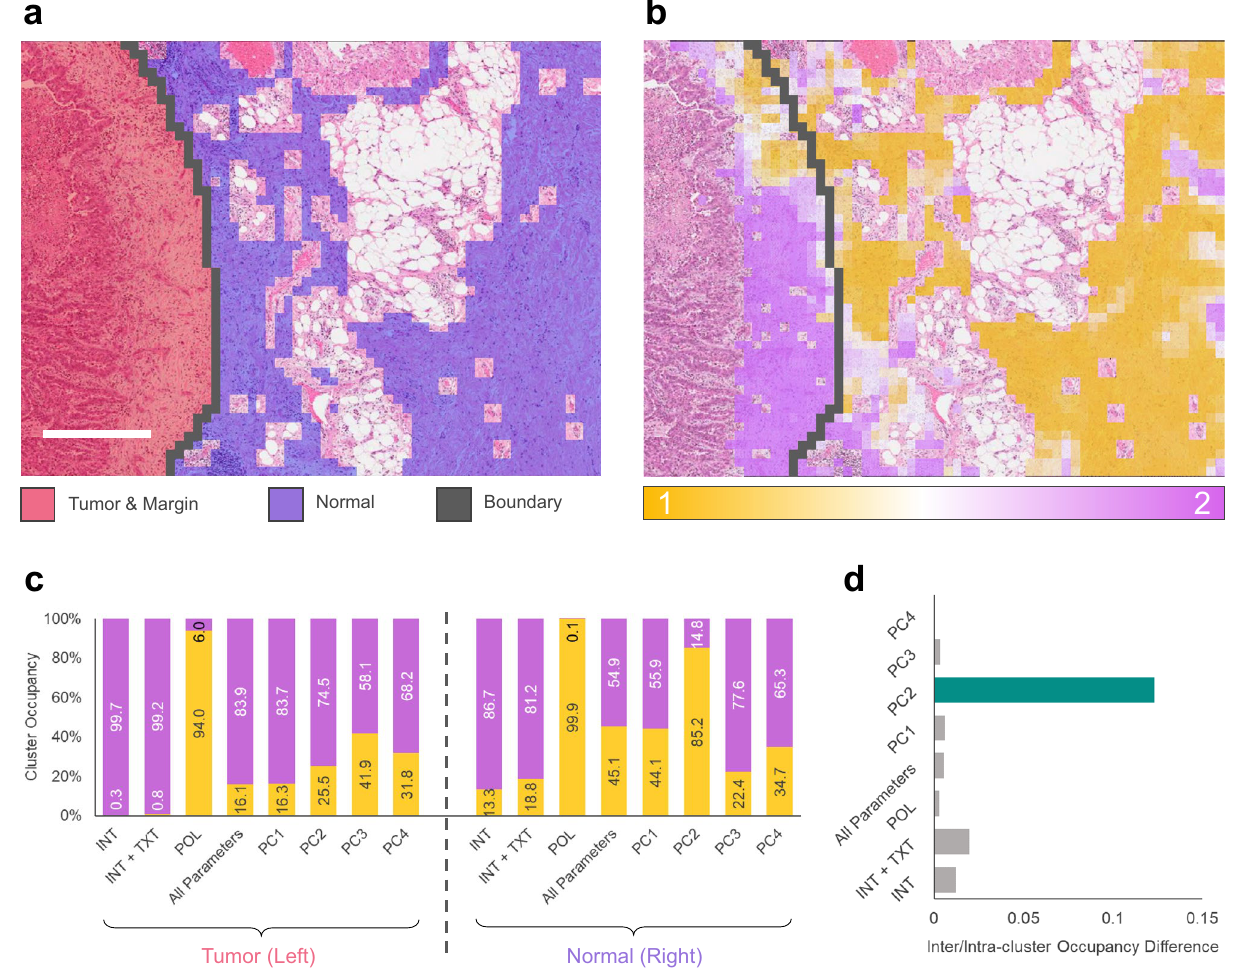
Figure 4. Tumor margin estimation. A ground truth map was generated to highlight the tumor mass and margin (red), as well as the normal tissue (blue) and the boundary in between (black) ( a ). The tumor-normal boundary was superimposed on the H&E and the K-Means clustered image with PC2 data subset. The normal side mainly corresponds to cluster 1 and the tumor side is main associated with cluster 2 ( b ). Cluster occupancy barplot shows subset PC2 is the only data subset whose occupancy is reversed across the boundary ( c ). Difference between intra-cluster and inter-cluster occupancy across the boundary shows PC2 is best equipped to identify the tumor margin ( d ). Scale bar 500 µ Using the ground truth boundary, the image was divided into tumor and normal regions. The boundary was then superimposed on each of the data subsets introduced previously. Figure 4b illustrates the superposition of the boundary, the PC2 K-Means map, and the H&E image. As evident from Fig. 4b, the tumor side of the boundary mostly contains magenta-colored cluster 2 sub-images, while the normal side predominantly contains yellow cluster 1 sub-images. This behaviour was previously hinted by the crude vertically averaged plot of Fig. 3k. To further quantify this observation, the spatial occupancy of each cluster was computed for the tumor and normal sections. The cluster occupancy was computed as a ratio of the continuous score weighted average of sub-images in each cluster, over all sub-images on each side (details can be found in “Methods”). As shown in Fig. 4c, the cluster occupancy of the K-Means maps for each data subset were computed for both sides of the boundary. There are 2 criteria for effective differentiation of the tissue type across the boundary: (1) occupancy of one cluster should be maximized on either side of the boundary, and (2) the cluster with the larger occupancy on one side of the boundary should have a minimal occupancy on the opposite side. It is apparent that for most data subsets, the first condition is fulfilled since cluster 2 (magenta) seems to be prevalent for all but the 3rd data subset (POL), where cluster 1 accounted for the overwhelming majority of the occupancy. However, this condi- tion is apparent on both sides of the boundary for all but one data subset, corresponding to K-Means performed with PC2. As such, PC2 was deemed to be suitable in identifying the tumor boundary. Both required criteria were combined into a single parameter, namely, the inter/intra-cluster occupancy dif- ference (IIOD), which accounts for the inter-cluster occupancy difference on each side of the boundary, as well as, intra-cluster occupancy difference across the boundary (details can be found in “Methods”). The results of the IIOD computation is illustrated in Fig. 4d. As determined by IIOD, it is clearly apparent that K-Means performed